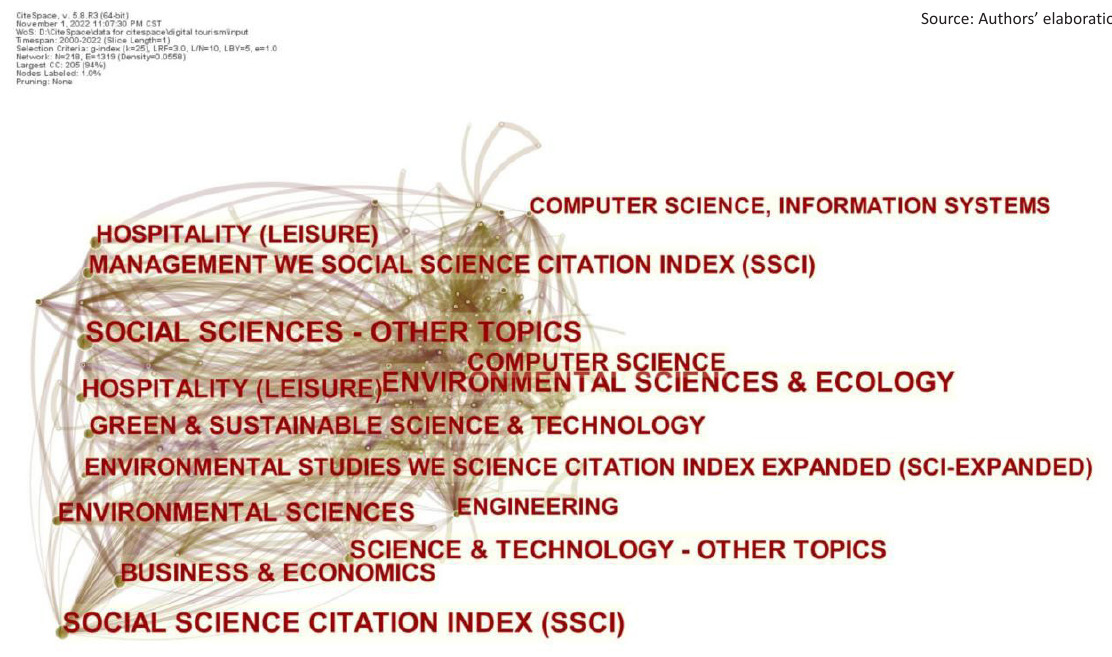
Figure 5. Knowledge map of disciplines distribution in digital tourism Table 4. Disciplines distribution in digital tourism research